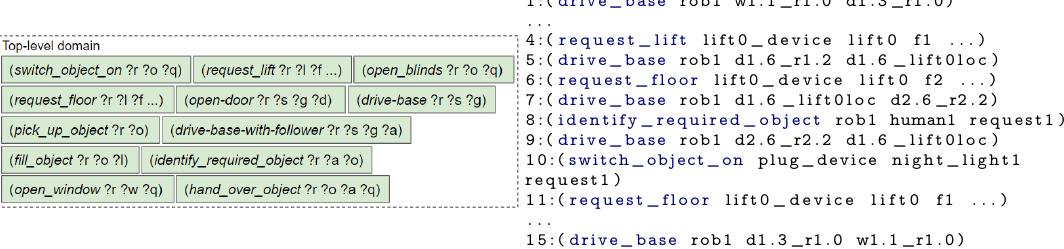
Figure 6. All actions definitions are contained within a single domain file. When planning everything upfront, the planner must make an assumption on the most likely request and include all actions needed to fulfil that request. In all figures the following words are abbreviated: doorway is shortened to d, waypoint to w, room to r and floor to f. In all proceeding figures blue boxes (with downwards arrows) indicate composite actions and green is used for primitive